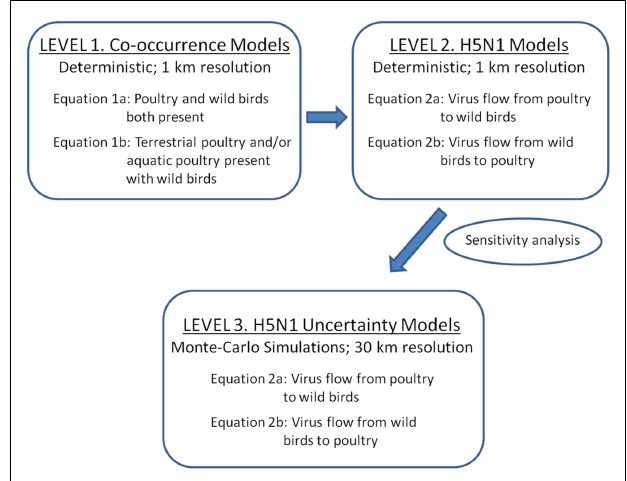
FIGURE 1 |Three levels of spatial models implemented for assessing H5N1 transmission risk between wild and domestic birds in China . Level 1 and 2 deterministic models were developed to refine the transmission equations (1km resolution). Level 1 models are co-occurrence models that predict where wild and domestic birds may come in contact. Level 2 models incorporate uni-directional equations for H5N1 transmission risk between poultry and wild birds. Level 3 models incorporate uncertainty using Monte-Carlo simulations at 30km resolution.